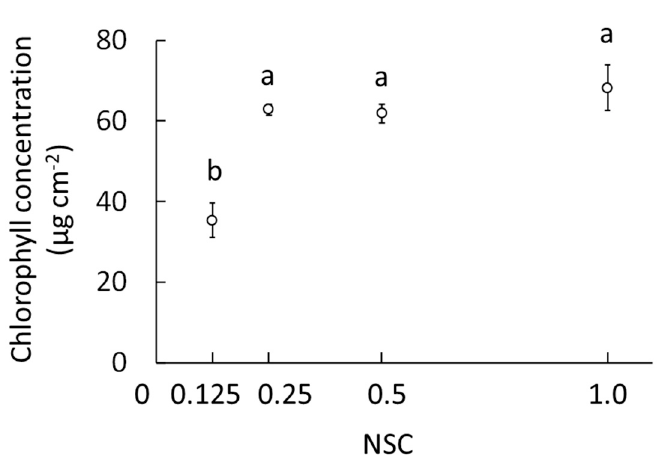
Figure 4. Effects of nutrient solution concentration (NSC) on the chlorophyll concentration in young leaves of O. pumila at 63 days after the start of the treatment (DAT) in experiment 1. The treatments were 0.125, 0.25, 0.5, and 1.0 NSCs. Vertical bars indicate S.E. ( n = 8). Different letters indicate significant differences among the treatments at p < 0.05 by Tukey–Kramer’s test.